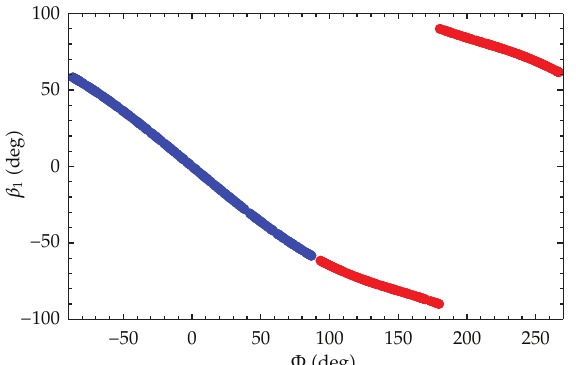
Figure 3: The Majorana CP phase β 1 as a function of φ plotted by the 1 σ experimental constraints (cid:2) 2.9 (cid:3) . The blue (cid:2) dark (cid:3) and red (cid:2) light (cid:3) curves correspond to the IH and NH spectra.